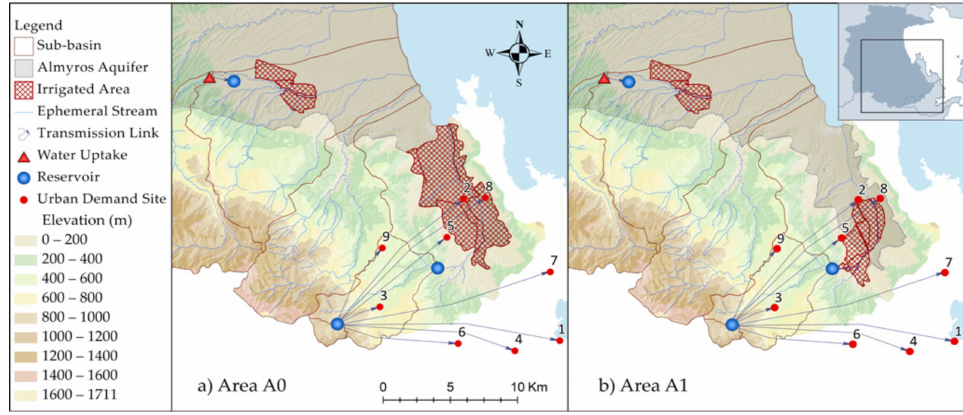
Figure 3. Reservoirs and the respective urban and agricultural water demand areas for ( a ) area A0 and ( b ) area A1, of the Almyros basin.